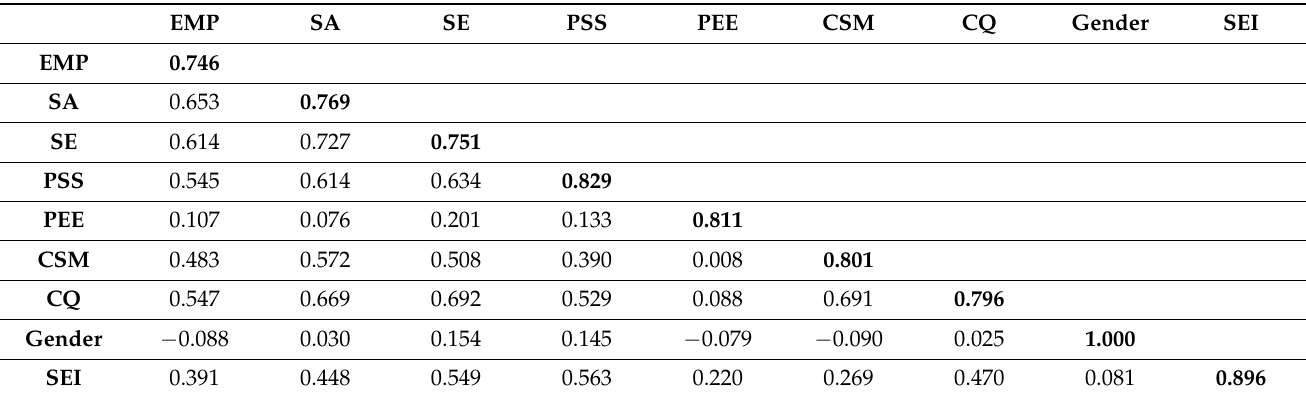
Table 7. Post-pandemic inter-correlation